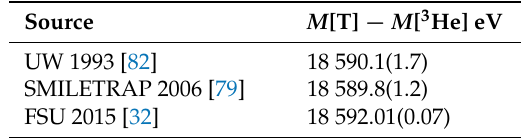
Table 6. Mass difference between atoms of tritium and helium-3, expressed in